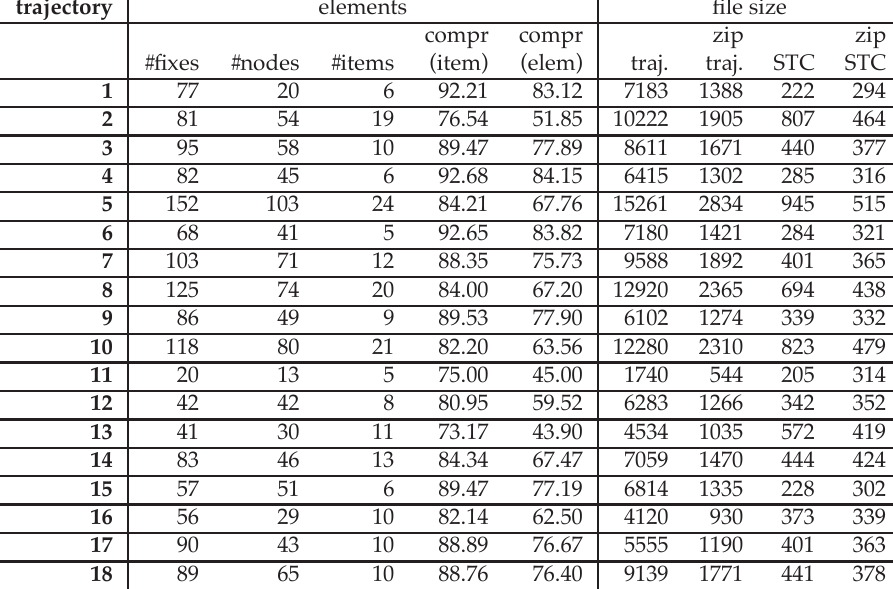
Table 2: Results of the 18 real world trajectories. compr(item) states the compression rate when comparing items of the compressed trajectory; compr(elem) the compression rate